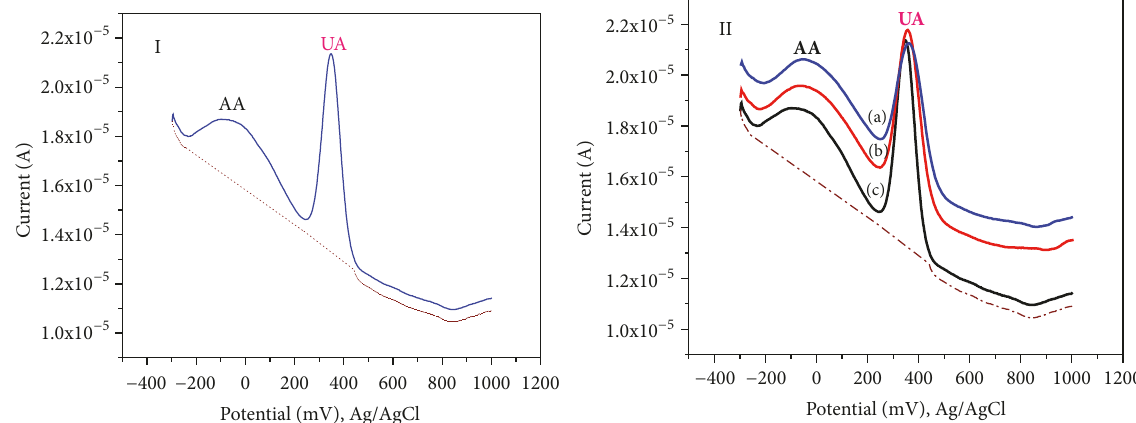
Figure5:DifferentialpulsevoltammetryofUA(1mM),AA(100 𝜇 M),and100 𝜇 MCAina0.1MPBS(pH7.0)and(II):differentconcentrations of UA (100 𝜇 M (a), 500 𝜇 M (b), and 1 mM (c)) in the presence of 100 𝜇 M each of AA and CA in a 0.1 M PBS (pH 7.0) at the DMF modified SPCE at scan rate of 10 mV/s, pulse amplitude of 240 mV, and pulse period of 100 ms.